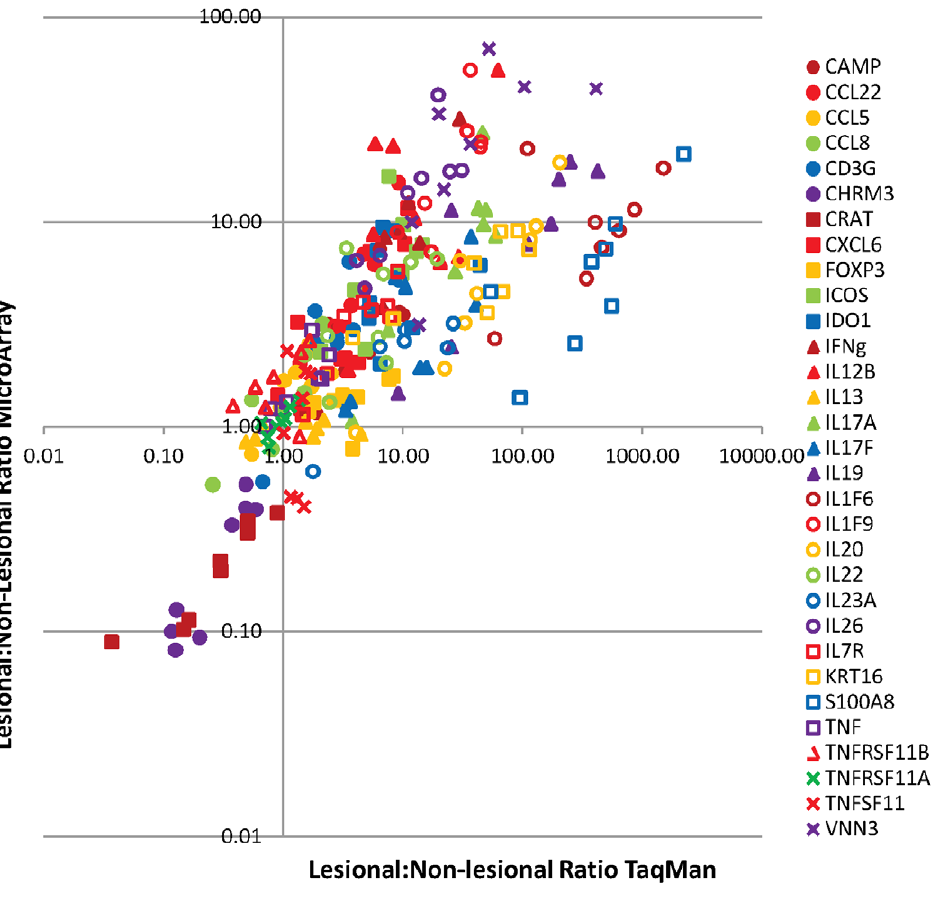
Figure 5. Comparison of Fold-changes in Psoriasis PP/PN Pairs by Microarray and qRT-PCR. Fold-changes for a selection of mostly immune system transcripts were assessed by qRT-PCR and microarray in a subset of eight psoriasis PP/PN skin biopsies from the Asterand set. Transcripts were selected based on relevance to psoriasis, range of expression level and range of fold-changes; patient biopsies were selected based on microarray data so that the range of differential expression was large. The black line indicates complete concordance.